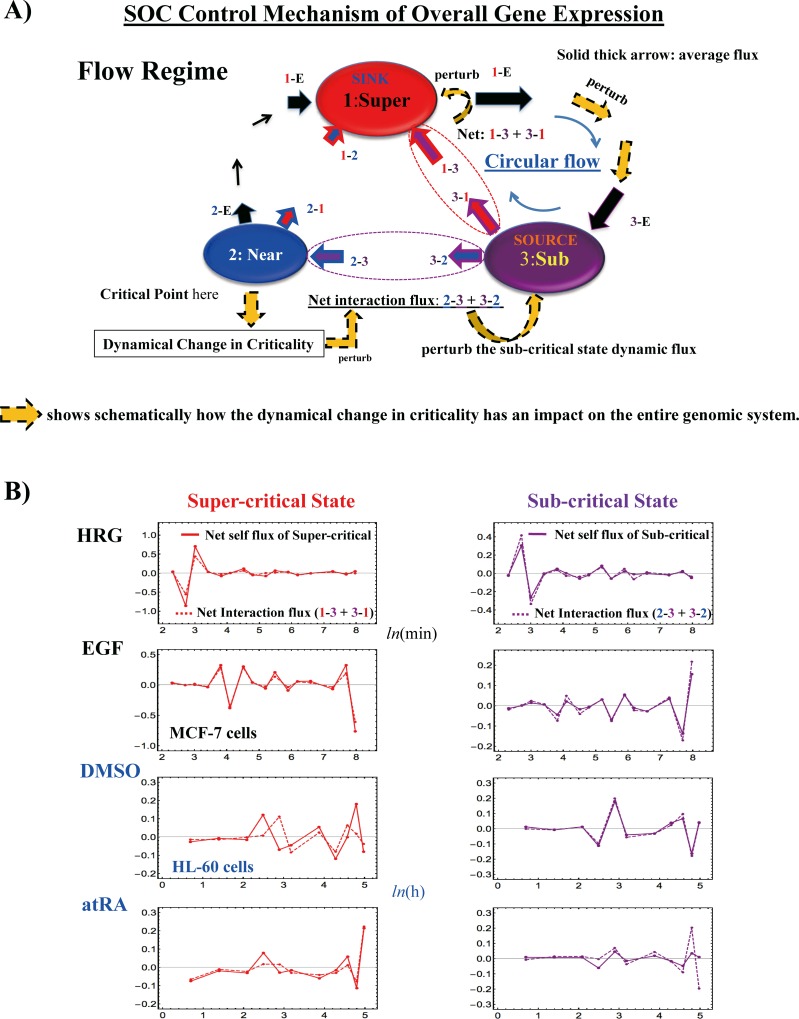
SOC control mechanism of overall gene expression in terminal cell fates (MCF-7 and HL-60 cells): A) Flow regime shows how a dynamical change in criticality (critical behaviors) at the CP in terminal cell fates affects the entire genome (thick yellow arrow with a black dashed outline) as follows (Super: super-; Near: near-; Sub: sub-critical state): The dynamical change in criticality (critical behaviors) that originates from the CP at Near perturbs the net interaction flux (2–3 + 3–2; refer to Fig 12A) at Sub-Near, which determines the net self-flux of Sub (B: right panels), and thus directly perturbs the Sub-response. This induces a perturbation in the net interaction flux of Sub-Super (1–3+3–1), i.e., directly perturbs the Super-response (B: left panels). Furthermore, these perturbations on Sub and Super disturb the dominant cyclic flux between Sub and Super, which in turn has an impact on sustaining the critical dynamics (source: Sub and sink: Super); solid thick arrows represent average fluxes (Table 2). Note: the net self-flux of a critical state represents the effective driving force acting on CM, and thus dynamic interactions among states determine the coherent oscillatory dynamics of Sub and Super (Fig 11). This schematic picture also shows that the erasure of an initial-state criticality at the genome-state change reflects the destruction of the initial-state SOC control on the dynamical change in the entire genomic system (i.e., pruning procedure for regulating global gene expression at the initial state).